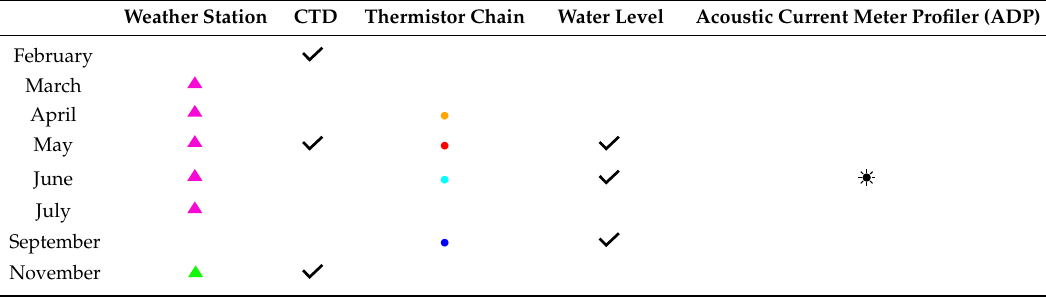
Table 1. Dates and instruments used in each campaign.